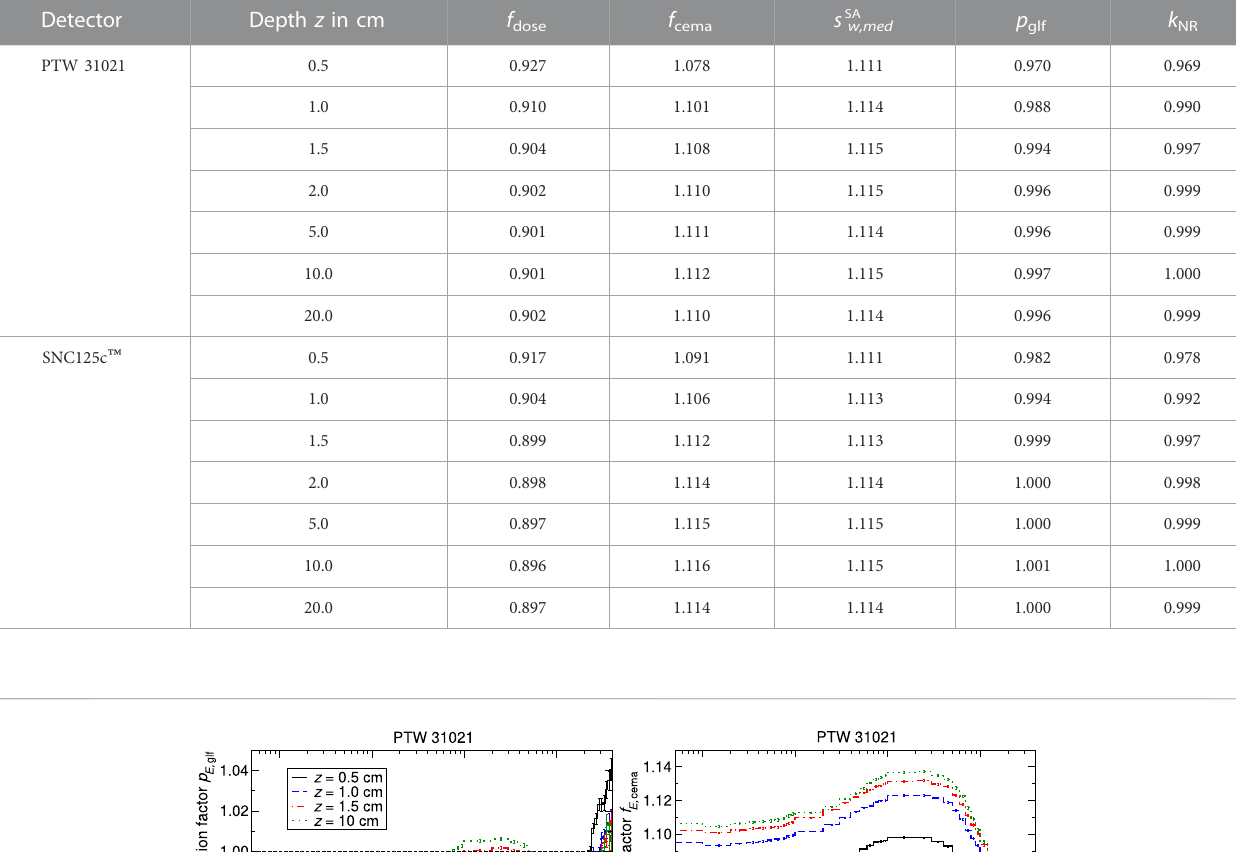
TABLE3MonteCarlocalculated fl uencecorrection,cema-aswellasdoseconversionfactorsforcylindricalair- fi lledionizationchambersasafunctionofdepthinwater irradiatedwitha6 MVlinearaccelerator x-rayspectrumtakenfrom[26]fromacollimatedpointsourcewitha fi eld-sizeof10 cm×10 cm.Theuncertaintiesvarybelow 0.1% for all calculated